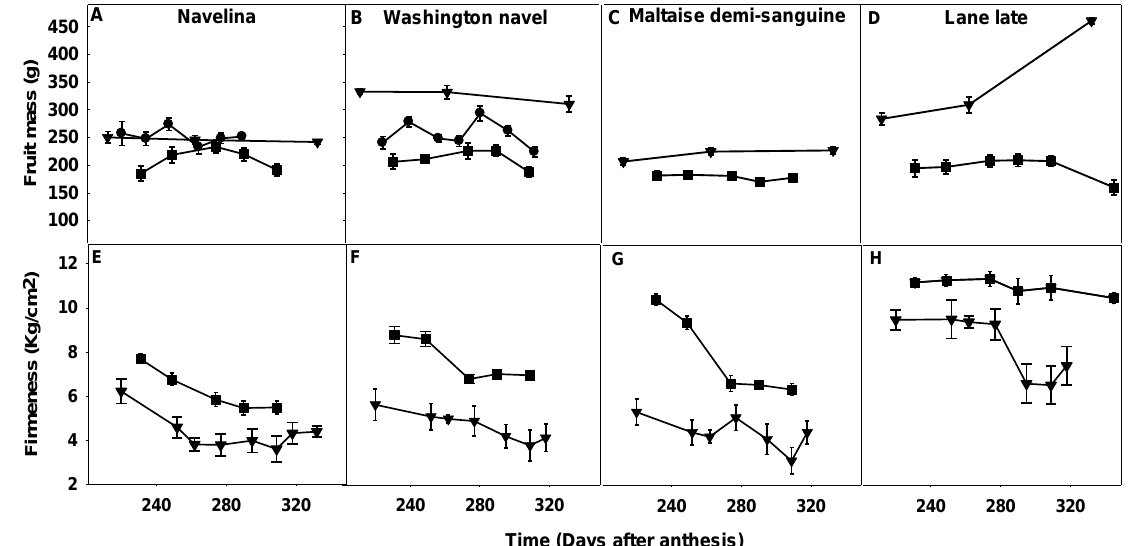
Figure 3. Fruit mass and firmness measured in different orange cultivars during maturation in Corsica ( (cid:72) ) , Spain ( • ) and Tunisia ( (cid:4) ). Fruit mass was measured in ( A ) ‘Navelina’, ( B ) ‘Washington navel’, ( C ) ‘Maltaise demi-sanguine’ and ( D ) ‘Lane late’. Firmness was measured in ( E ) ‘Navelina’, ( F ) ‘Washington navel’, ( G ) ‘Maltaise demi-sanguine’ and ( H ) ‘Lane late’. Values are means ± SE ( n = 12). Anthesis occurred in the first, second and fourth week of April, 2012 in Tunisia, Spain and Corsica respectively. In the graphs, day 150 after anthesis thus corresponds to 09 / 26 / 2012 in Corsica, 09 / 12 / 2012 in Spain, and 09 / 07 / 2012 in